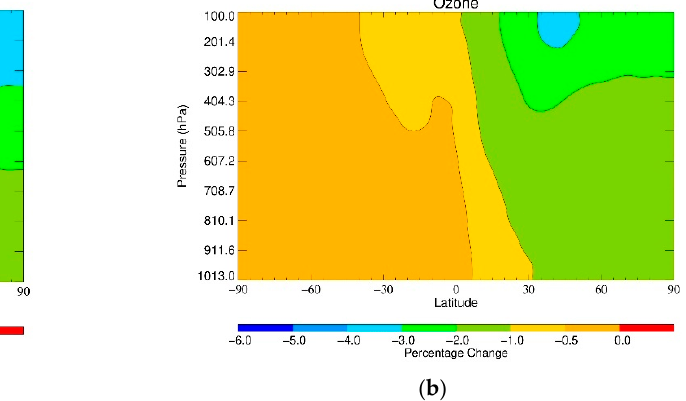
Figure 4. The percentage zonal change of ozone mixing ratio from ( a ) STOCHEM-base to STOCHEM-75NO x scenario, ( b ) STOCHEM-base to STOCHEM-50NO x scenario. Note: The approximate height equivalent to the pressure in the y -axis can be found in Appendix A (Table A1). STOCHEM-75NO x shows a maximum decrease in ozone mixing ratios of ~6% at 11.8–16.2 km (201–100 hPa) starting from 20 °N to 50 °N over eastern North America, mainland Europe and the transatlantic corridor (Figure 5). The trend is mirrored on a slightly smaller scale (reduced by 4%) in the case of the change of ozone mixing ratios from STO- CHEM-base to STOCHEM-50NO x .